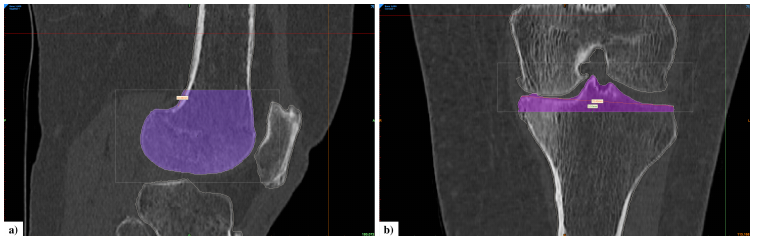
Figure 2. ( a ) Cropped mask of femur bone in sagittal view. ( b ) Cropped mask of tibia bone in coronal